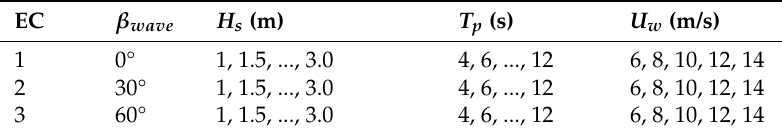
Figure 7. Description of North sea center offshore site ( a ) marginal PDF of mean wind speed ( f U ( b ) 2D-contour surface for H s - T p for different ranges of wind speeds ( c ) wind–wave misalignment ( β wave ) ( d ) bird view of wind-turbine blade-root mating task. Table 2. Environmental load cases considered in this